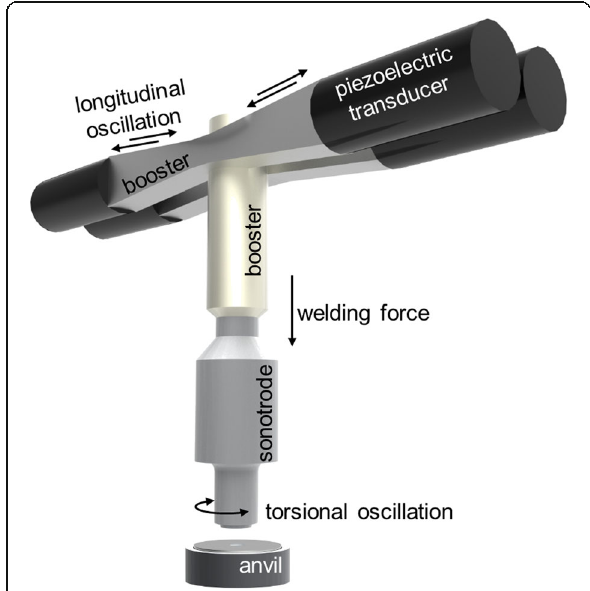
Fig. 3 CAD Model of the oscillation unit and the anvil of a torsional welding machine Telsonic TSP 9000